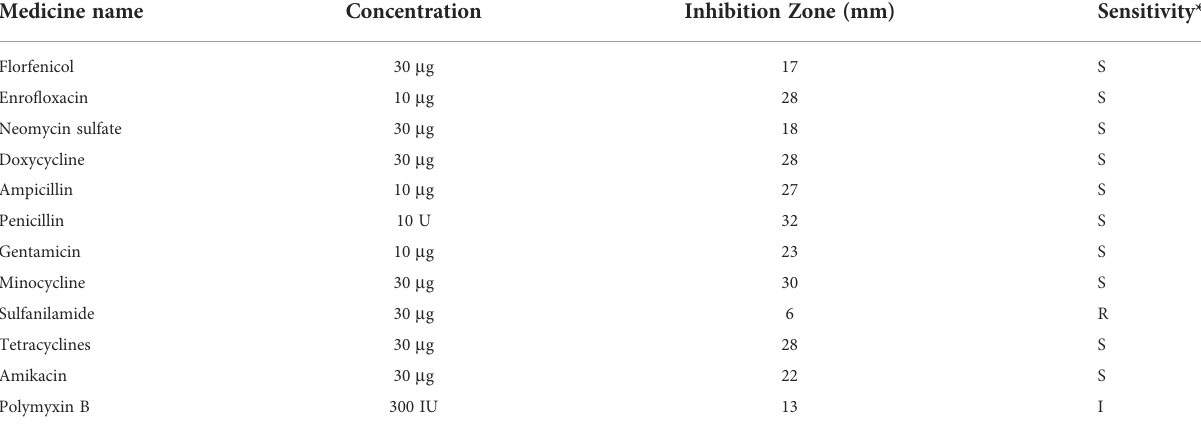
TABLE 2 D-59 Antimicrobial susceptibility